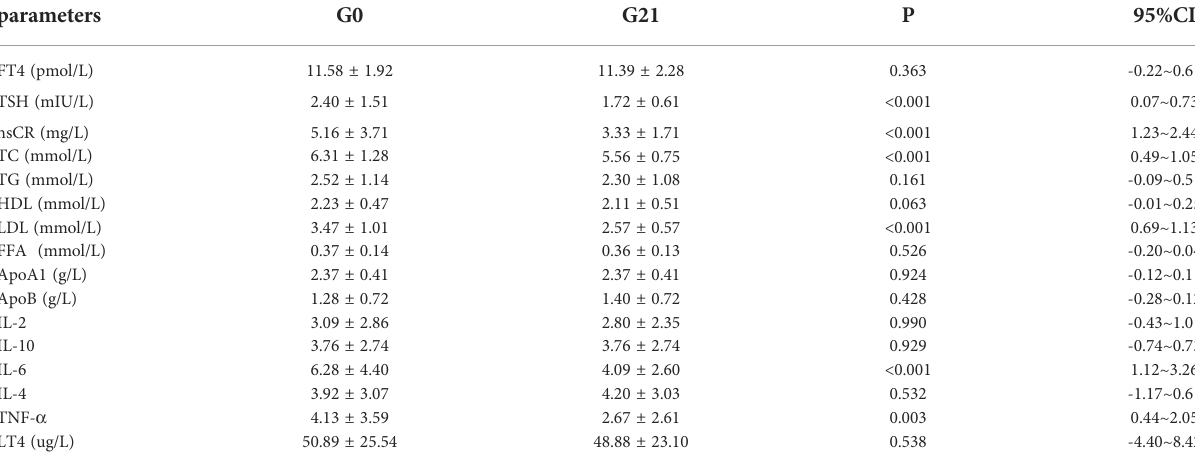
TABLE 6 Parameter changes after 0 (G0) and 21 (G21) days of